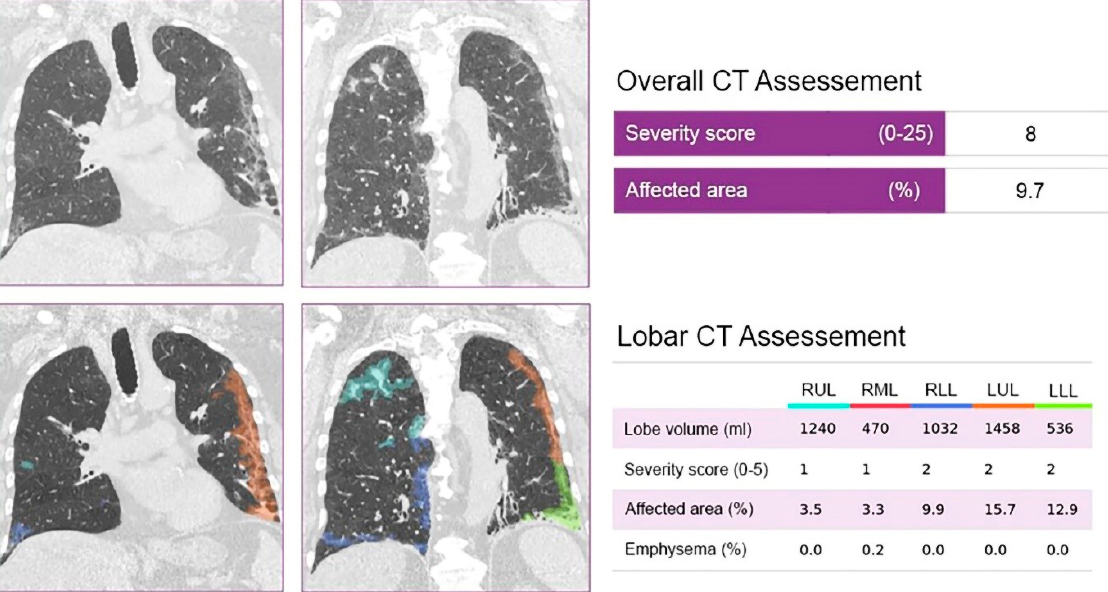
Figure 1. Representative example of the AI-based CAD4COVID–CT software of a patient with a total CT severity score of 8. The original and AI–assessed chest–CT of a 67–year old male patient, who was hospitalized with an SpO2 of 95% at the time of hospital admission. The patient was receiving chemotherapy for prostate cancer at the time of the CT scan. As a result of the standard therapy, the patient experienced gradual improvement in his condition during hospitalization and was released home after 10 days. CT severity scores, affected areas, lobe volumes and emphysema areas are reported on the right side. Severity scores were calculated using the percentage of the affected area of the parenchyma. Abbreviations: CT = computed tomography